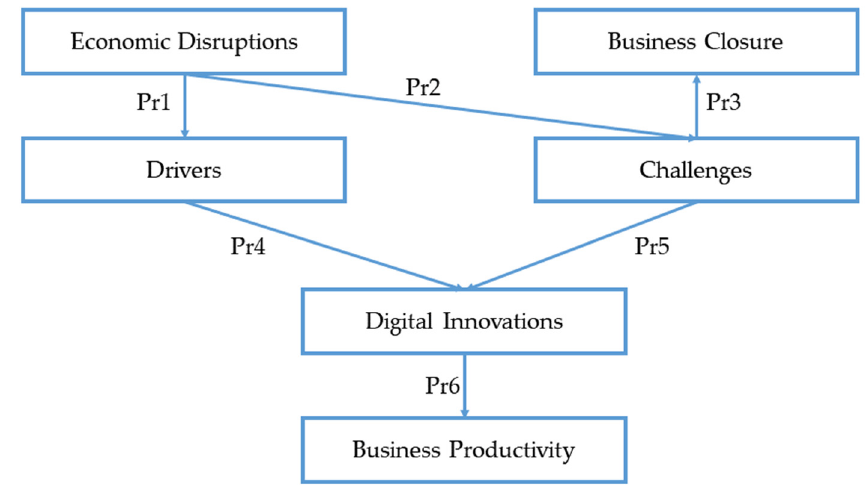
Figure 1. Research Framework and Prepositions of the Study.